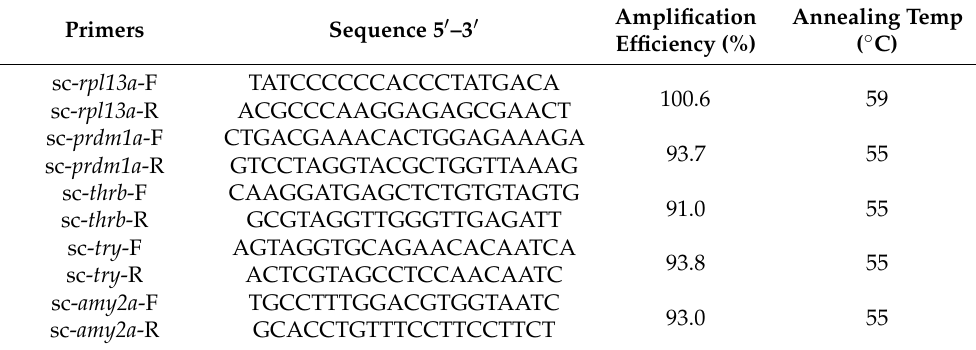
Table 1. Primers used for